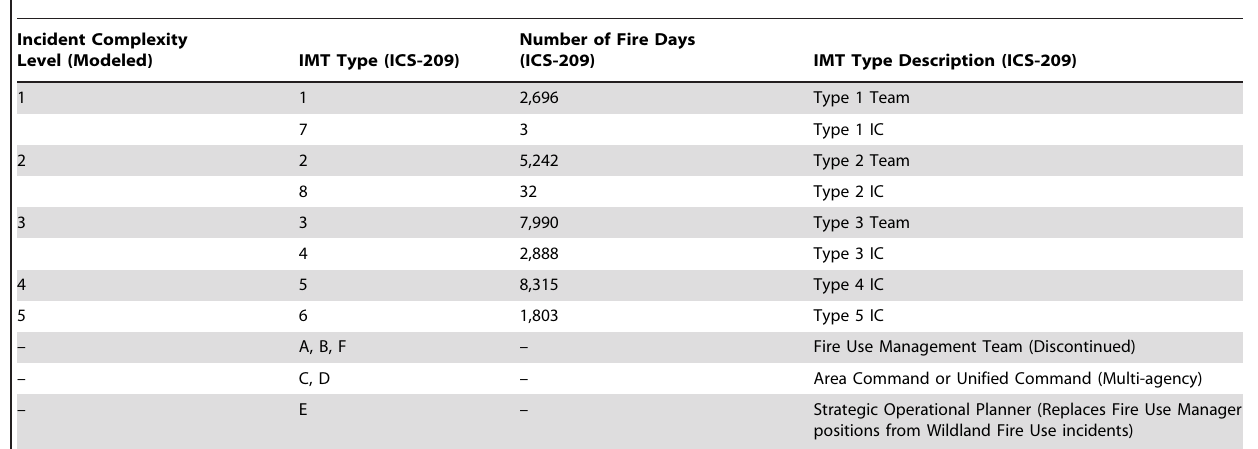
Table 1. IMT types, number of fire day observations, descriptions, and usage in the incident complexity analysis.